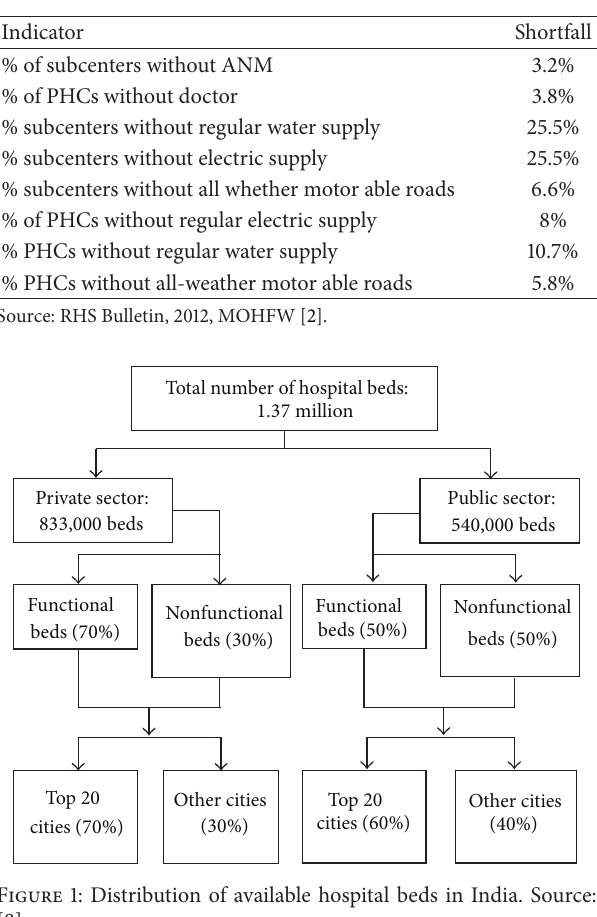
Table 3: Some of the deficiencies in the available infrastructure.